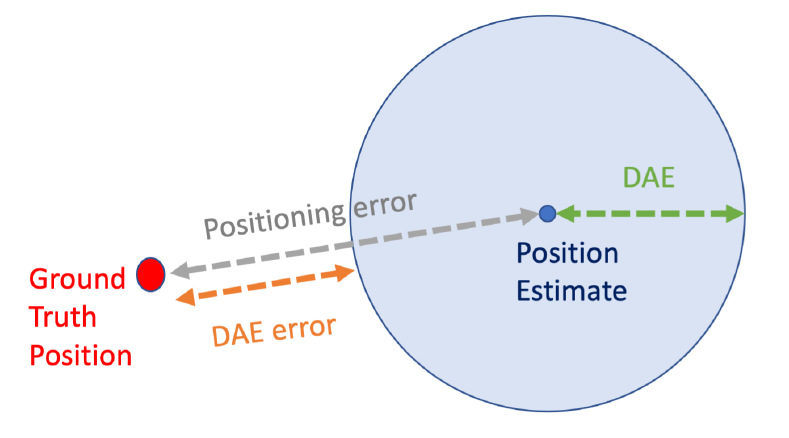
Figure 1. Visualizing the actual positioning error and the